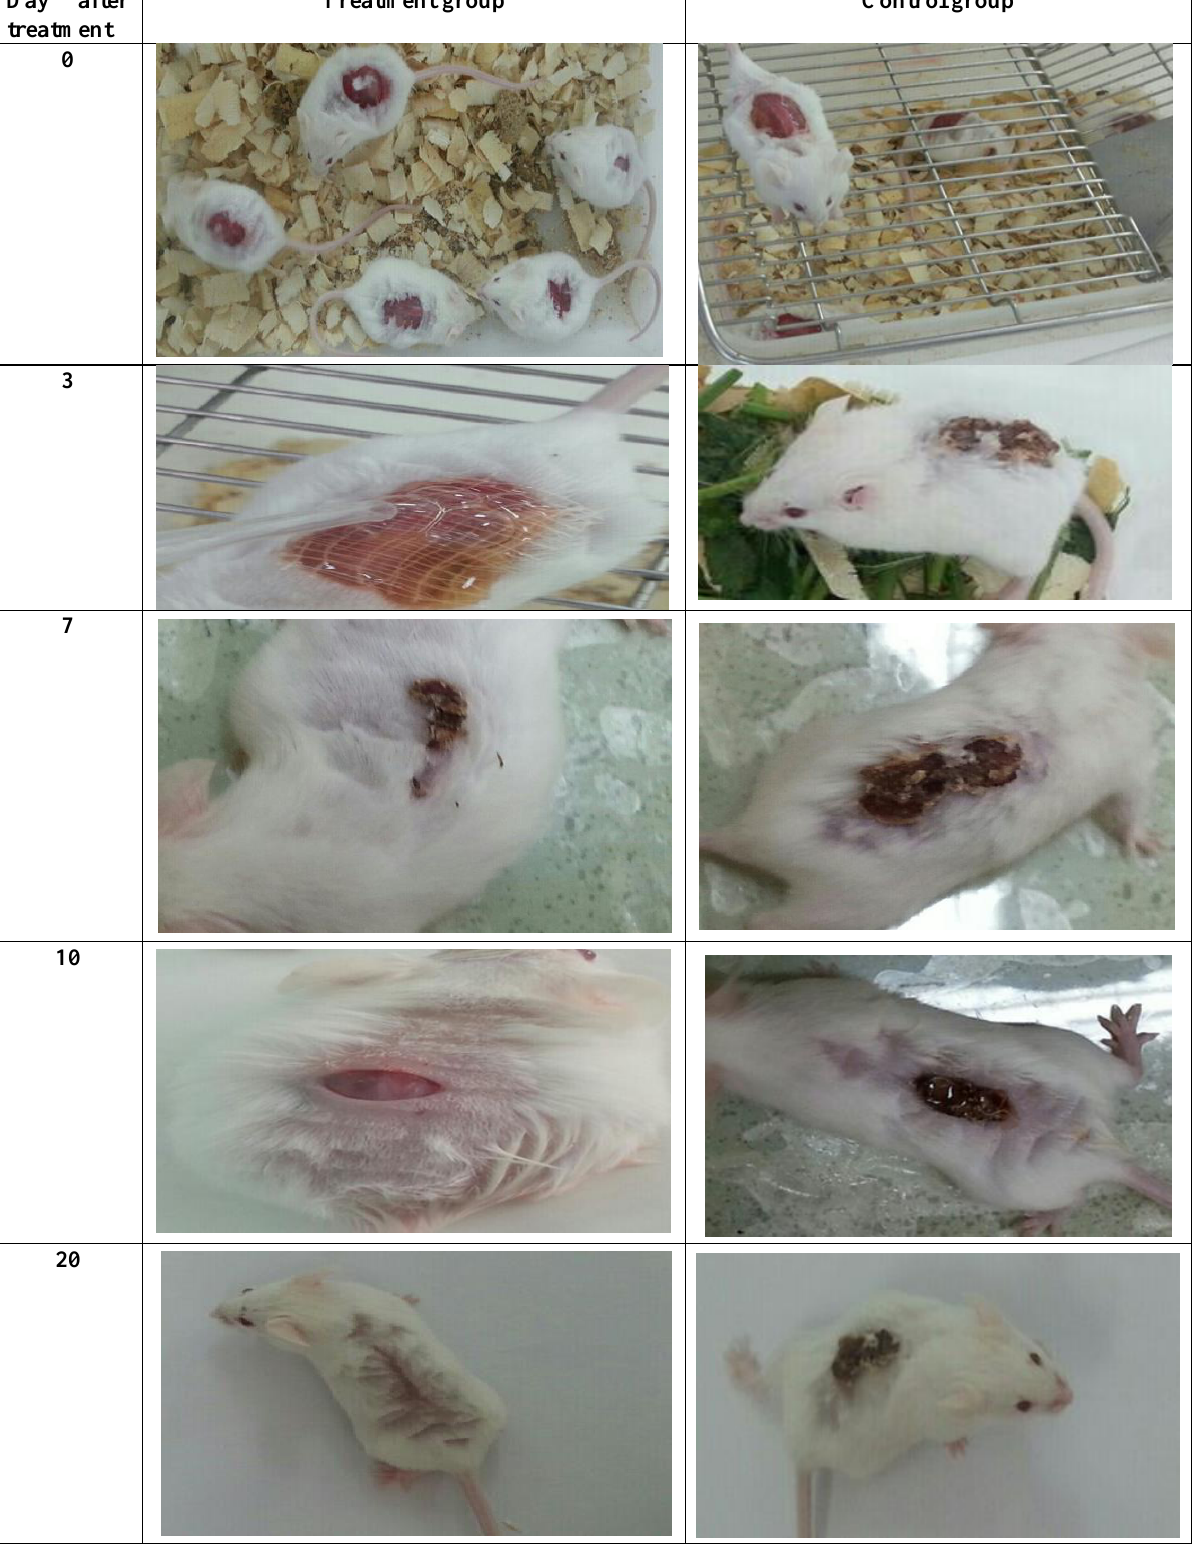
Figure 2. The difference in healing process between the mice treated with HUCS in comparison with control without